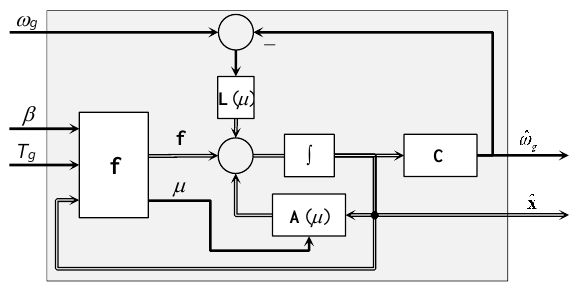
Figure 2. Observer configuration for the estimation of state variables and effective wind speed.